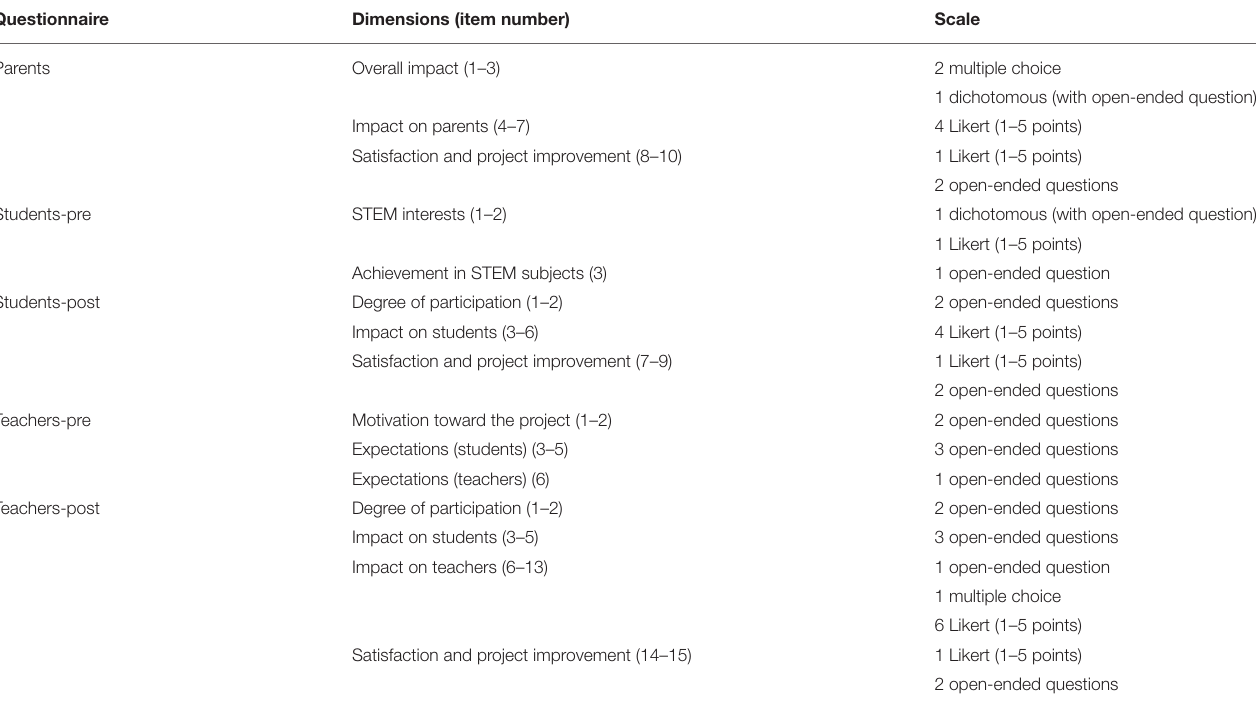
TABLE 2 | Design of the questionnaires (v1). Questionnaire